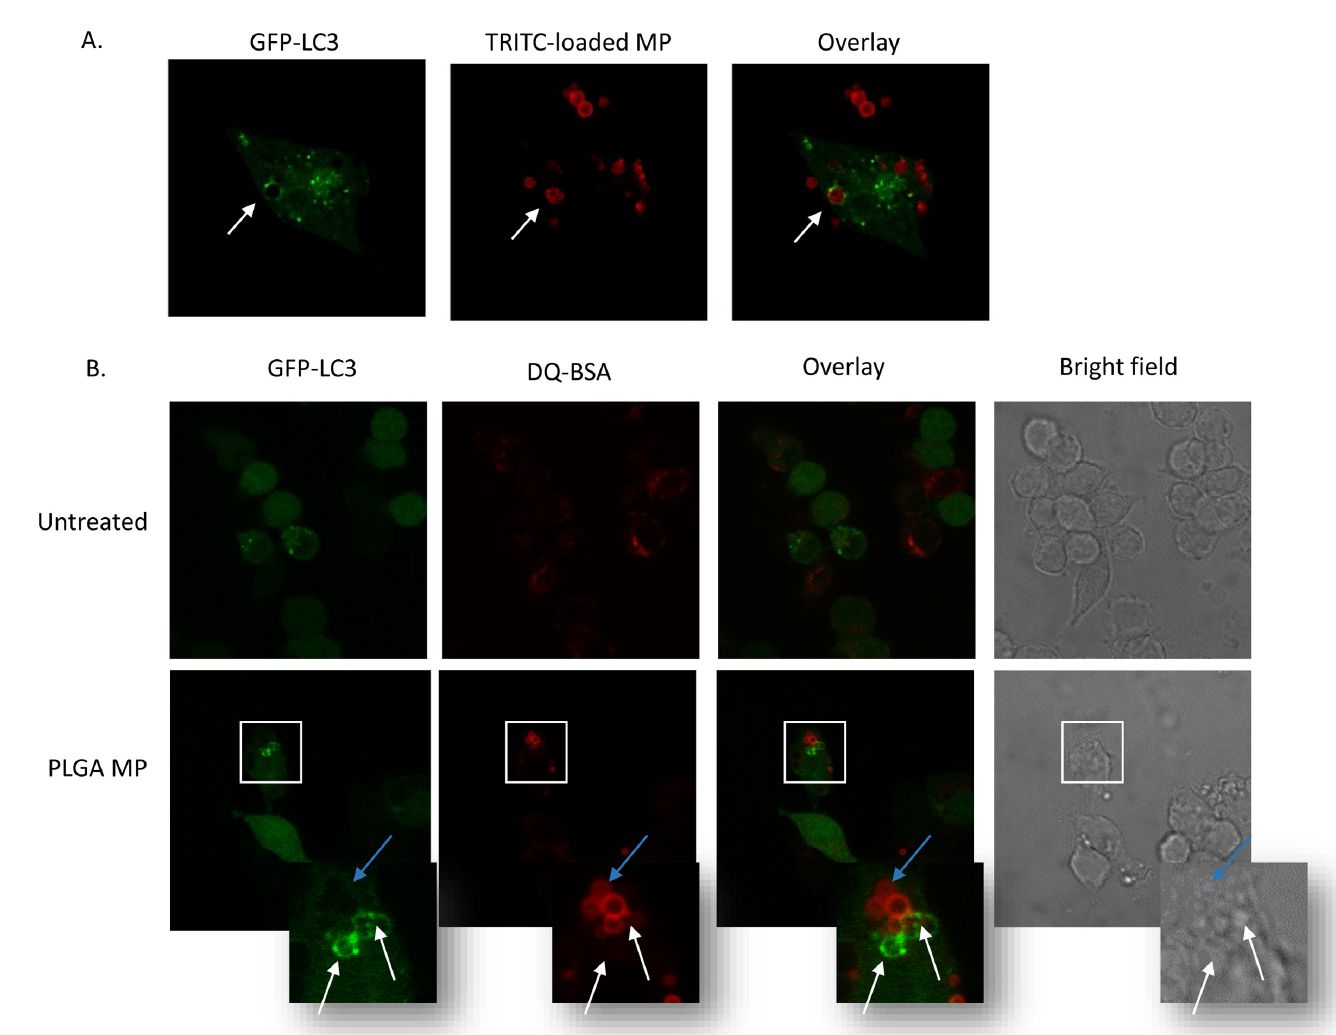
Fig 4. PLGA MPs co-localise with LC3 following phagocytosis by macrophages. Live confocal microscopy images of immortalized murine BMDMs expressing GFP-LC3 were acquired using a ×63 oil objective following incubation with (A) TRITC-loaded MPs (red) for 3h, or (B) pre-loaded with DQ-Red- BSA for 2 hours to visualize lysosomes, washed, rested for 1 hour in medium without DQ-Red-BSA and then incubated with blank PLGA MPs (200 μ g/ml) for 1h. The white arrows indicate localization of GFP-LC3 with MPs, blue arrows indicate localization of lysosomes with MPs. The results shown are representative of five independent